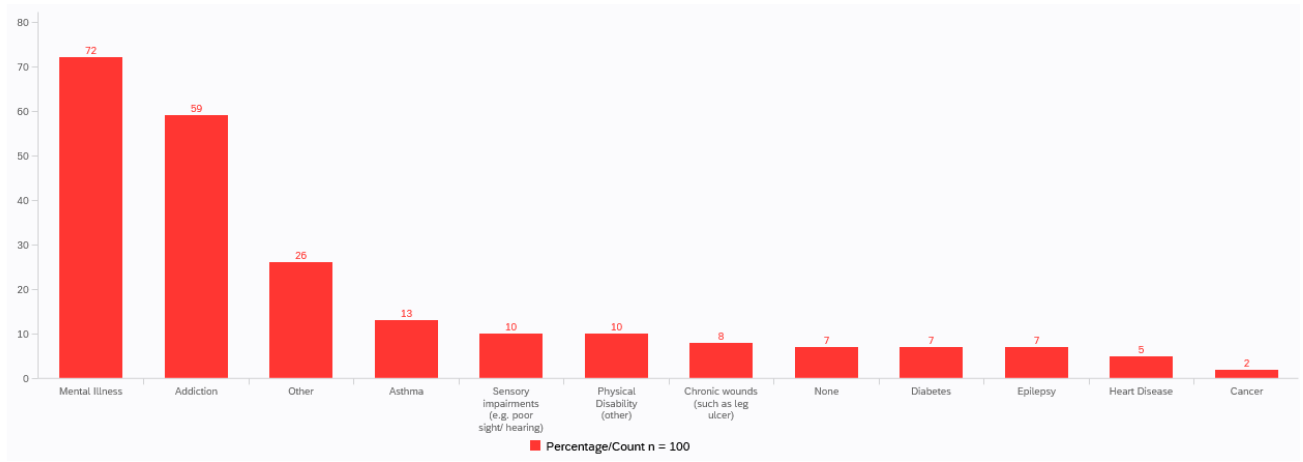
Figure 1. Range of health